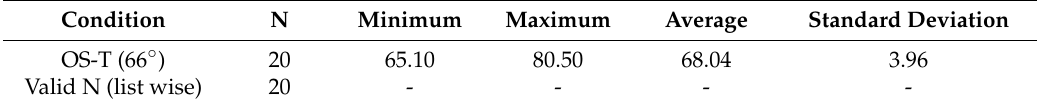
Table 18. Descriptive Statistic of empirical noise level data on the 66° oriented building to runway. Condition N Minimum Maximum